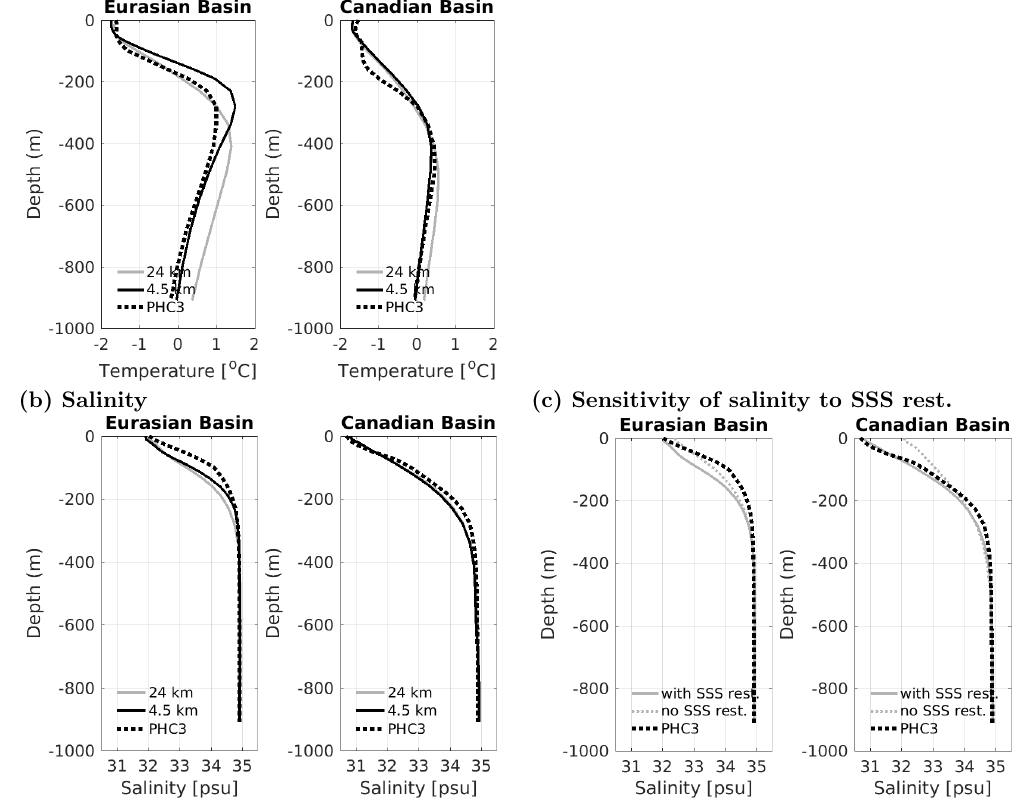
Figure 5. (a) Mean temperature profiles in the Eurasian and Canadian basins in the low- and high-resolution simulations. (b) The same as panel (a) but for salinity. (c) The same as panel (b) but for comparing two low-resolution simulations with and without sea surface salinity (SSS) restoring. Model results are averaged from 1980 to